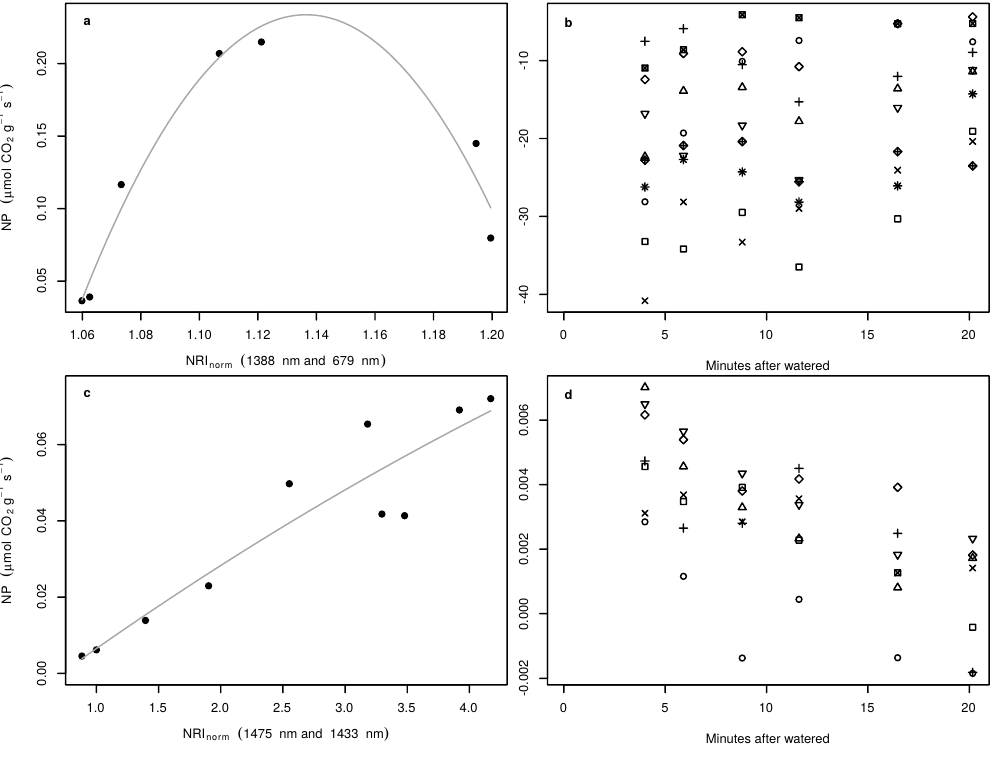
Figure 6. Relationships between NP of Acarospora cf. gypsi-deserti in the laboratory and the index with the highest proportion of explained variance ( a ). The grey curve symbolizes the regression of the polynomial fit. Predicted NP of Acarospora cf. gypsi-deserti in the field in relation to the time passed since being watered ( b ). Symbols in ( b ) indicate individuals. Note that time is always the end time of the scan process, which took about 11 s for the entire image. ( c , d ) show the same, but for Caloplaca santessoniana